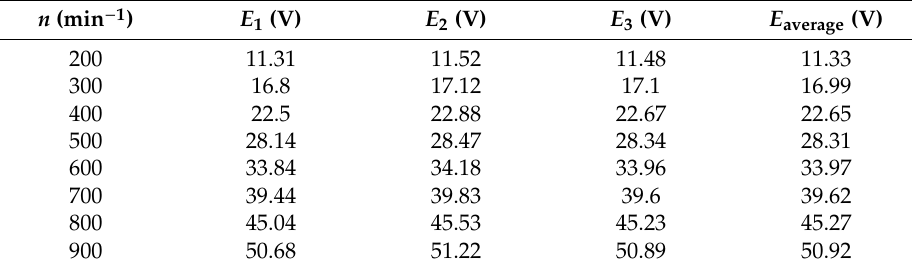
Table 7. Induced voltages as di ff erent rotation speeds.